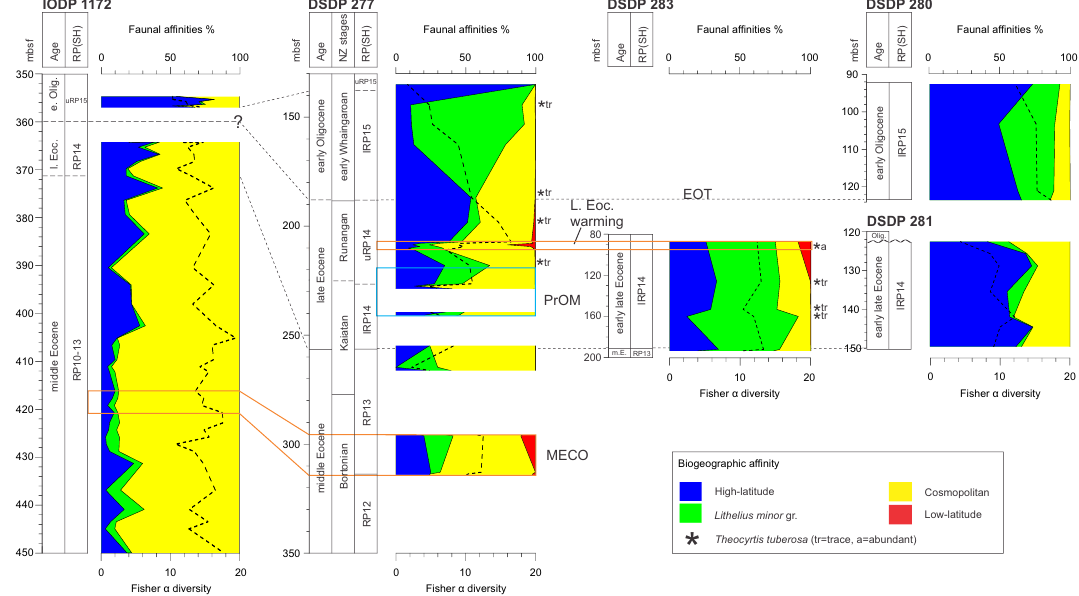
Figure 7. Variation in faunal affinities for radiolarian assemblages and Fisher α diversity at all sites. Dashed black lines indicate correlation between sites. The location of the MECO at Site 1172 is taken from Bijl et al.